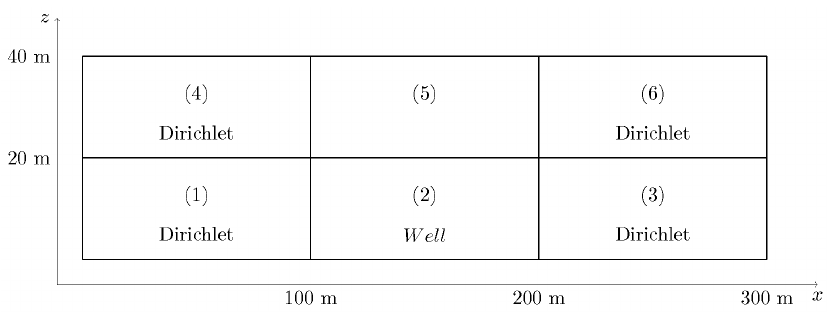
Figure 4. Scheme of the 2D domain used for the comparison